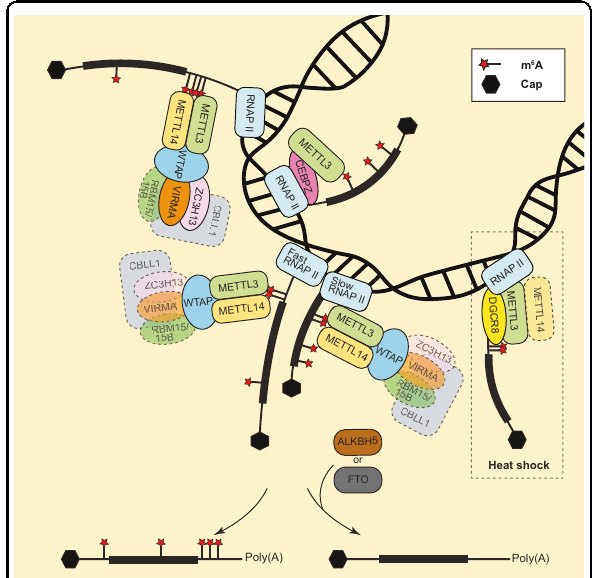
Fig. 1 An overview of cotranscriptional m 6 A mRNA modi fi cation. Introduction of m 6 A modi fi cation is currently suggested to occur cotranscriptionally in the nucleus. Individually transcribing mRNAs illustrate the different modes of cotranscriptional m 6 A modi fi cation, including different compositions of associated DNA- and RNA-binding proteins with distinct methylation sites. The thick line represents the coding sequence, and the thin line represents the UTR. The dashed box indicates the heat shock